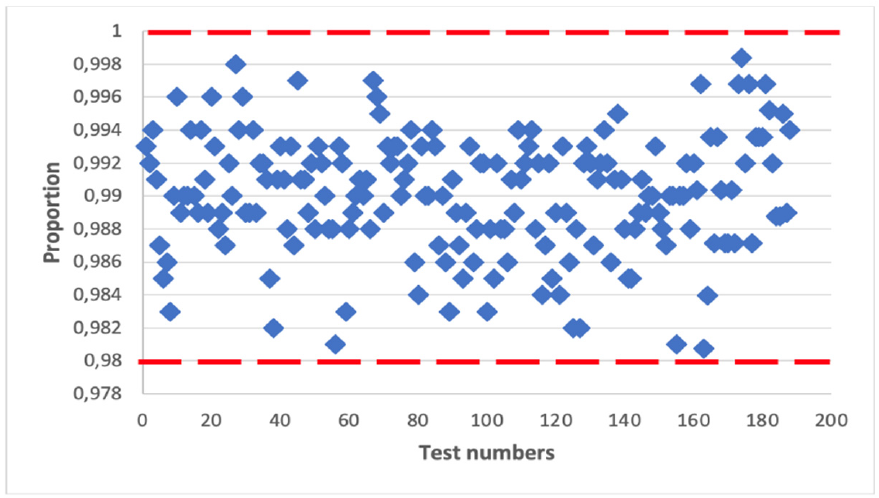
Figure 8. Statistical portrait of the AFG output sequence at p = 65,537 and X (0).